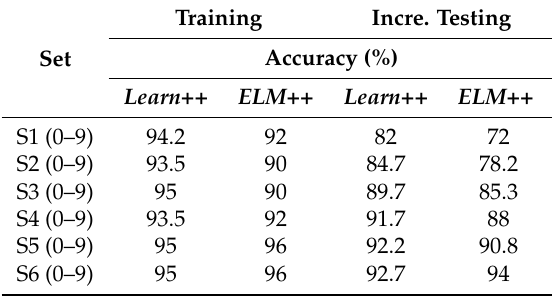
Table 4. Comparison of ELM++ and Learn++ – MNIST